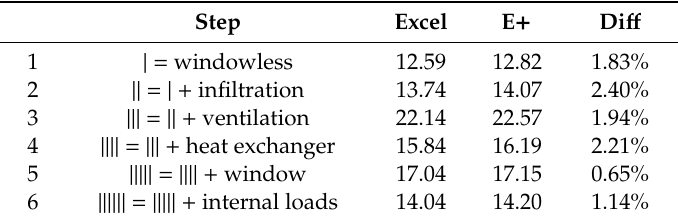
Table 1. Example of differences in results for the annual energy use intensity / (kWh/m 2 ) at different steps of the control method.